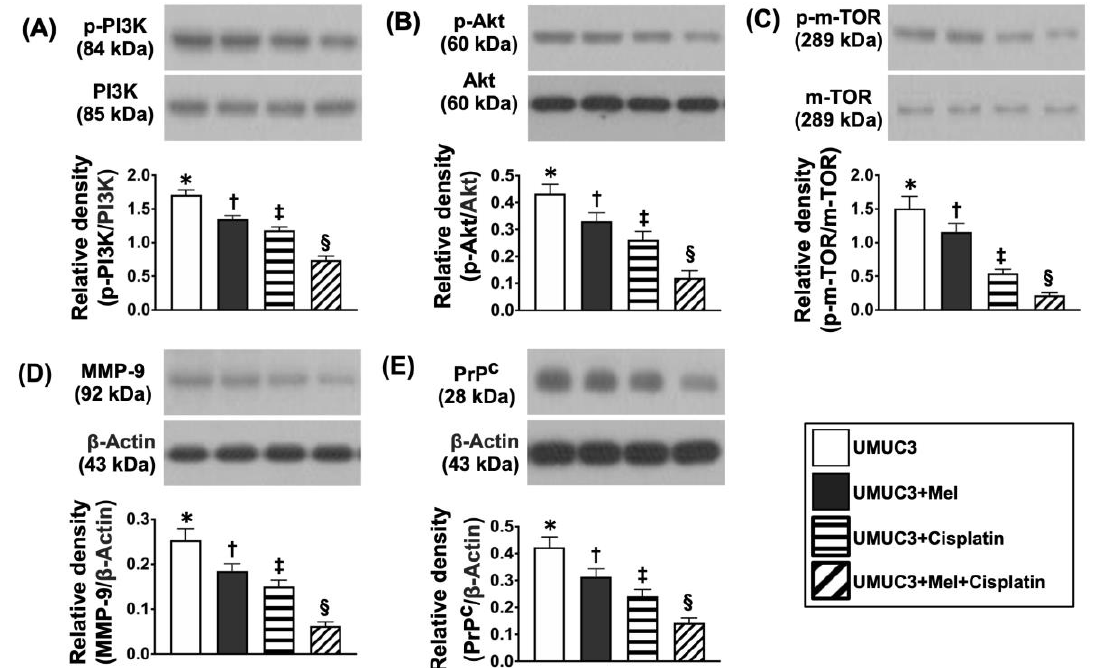
Figure 10. Protein expressions of cell survival/cell proliferation signaling on day 28 after UMUC3 engraftment into nude mouse backs. ( A ) Protein level of phosphorylated (p)-PI3K, * vs. different symbols (†, ‡, and §), p < 0.0001. ( B ) Protein level of p-Akt, * vs. different symbols (†, ‡, and §), p < 0.0001. ( C ) Protein level of p-m-TOR, * vs. different symbols (†, ‡, and §), p < 0.0001. ( D ) Protein level of matrix metalloproteinase (MMP)-9, * vs. different symbols (†, ‡, and §), p < 0.0001. ( E ) Protein level of PrP C , * vs. different symbols (†, ‡, and §), p < 0.0001. n = 6 for each group. Mel =